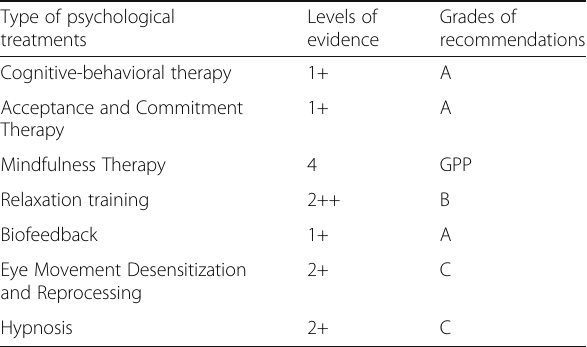
Table 3 Summary table of levels of evidence [181] and grades of recommendations of psychological treatments for primary headaches